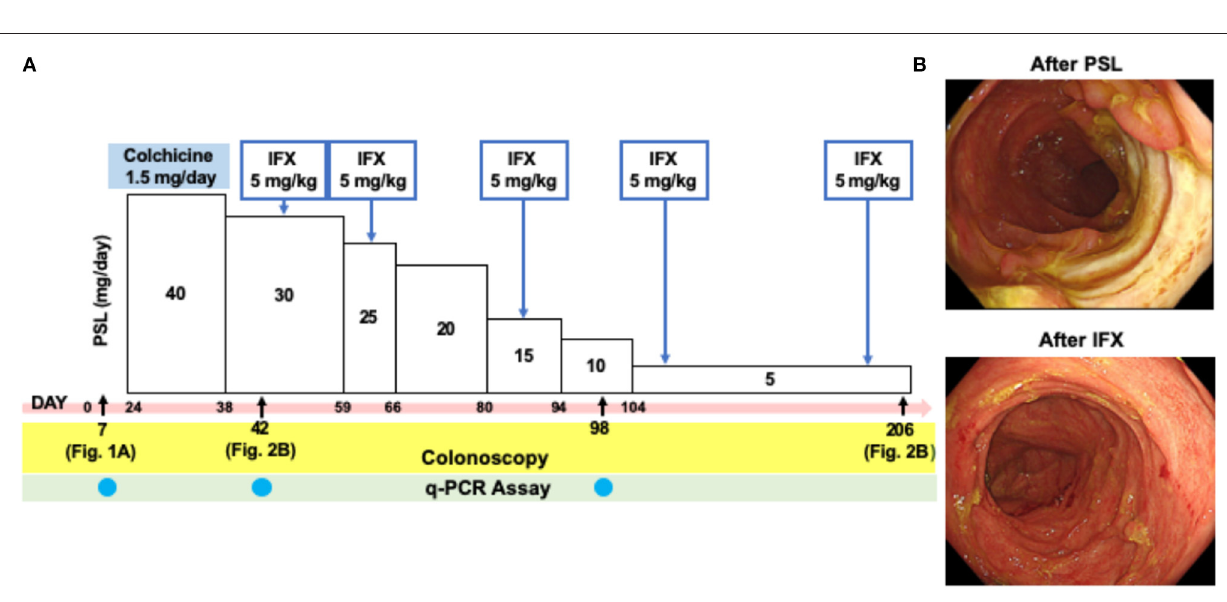
FIGURE 2 | Colonoscopic findings in a patient with intestinal Behçet’s disease after the treatment with prednisolone and infliximab. (A) Clinical course of a patient with intestinal Behçet’s disease. Day 0 was defined as on day of admission. (B) Colonoscopy performed after the treatment with prednisolone (PSL, Day 42) revealed semi-circumferential ulcers in the sigmoid colon. Disappearance of multiple ulcers was seen in the sigmoid colon after five times injections of infliximab (IFX, Day